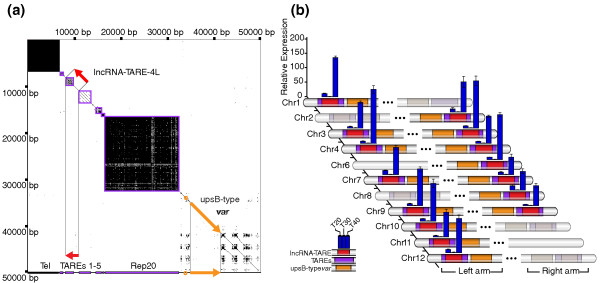
The telomere-associated lncRNA-TARE family neighbors upsB-type var loci and is coordinately expressed during parasite schizogony. (a) Dot plot analysis of the first 50,000 bp on chromosome 4 pinpoints lncRNA-TARE-4L in the TARE 2-3 region between the telomere (Tel) and a silenced upsB-type var virulence gene. (b) Subtelomeric features are diagrammed on the 11 chromosomes (Chr) from which we were able to specifically amplify lncRNA-TARE sequence. Features are not to scale, and grayed out chromosome ends were not probed. Notably, an upsB-type var gene (orange) is located adjacent to each predicted lncRNA-TARE gene (red). Furthermore, qRT-PCR amplification of 15 distinct lncRNA-TARE genes shows a coordinated pattern of late stage expression. lncRNA-TARE relative expression is plotted in time-points T20, T30, and T40 ± 3 hpi with respect to T30. Error bars represent the propagated standard error of the mean (pSEM) from two biological replicate experiments. Housekeeping gene PF08_0085 was used as the reference gene.